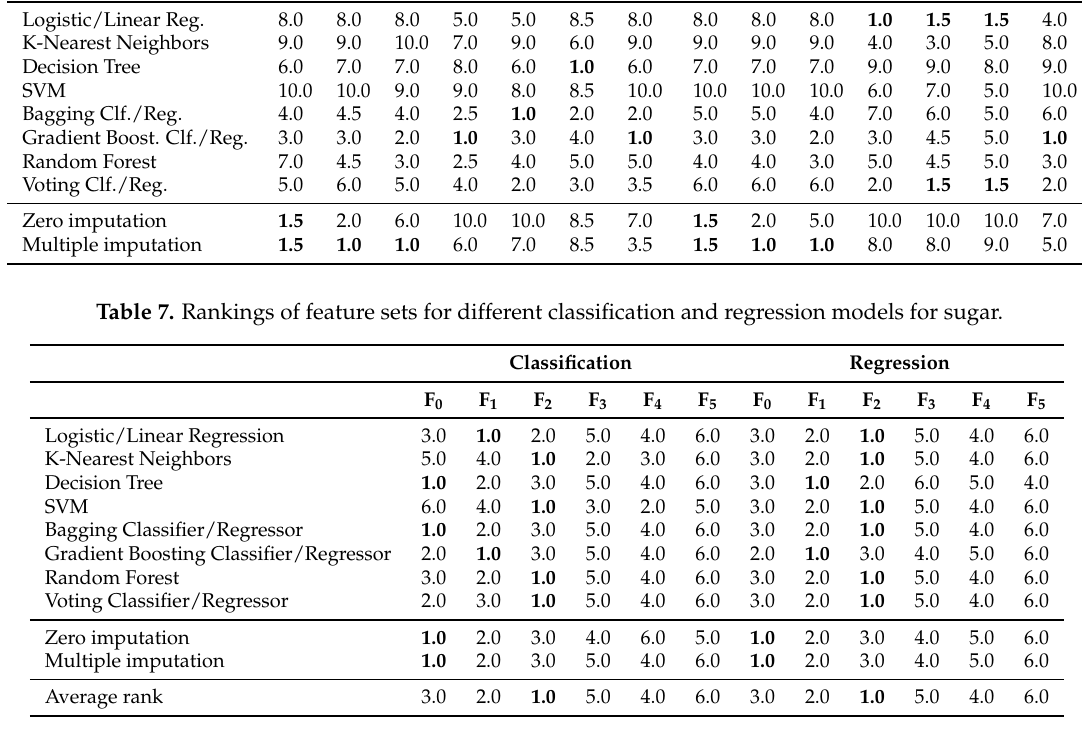
Logistic/Linear Reg.